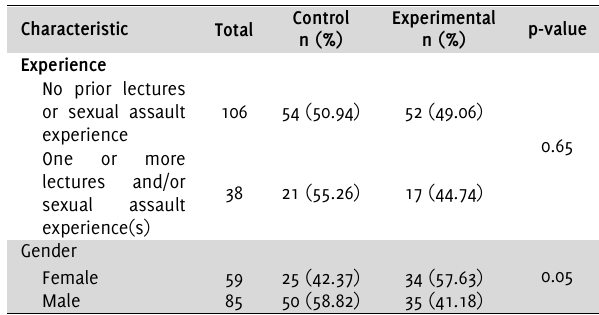
Table 1 . Experience and Gender Distributions by Student